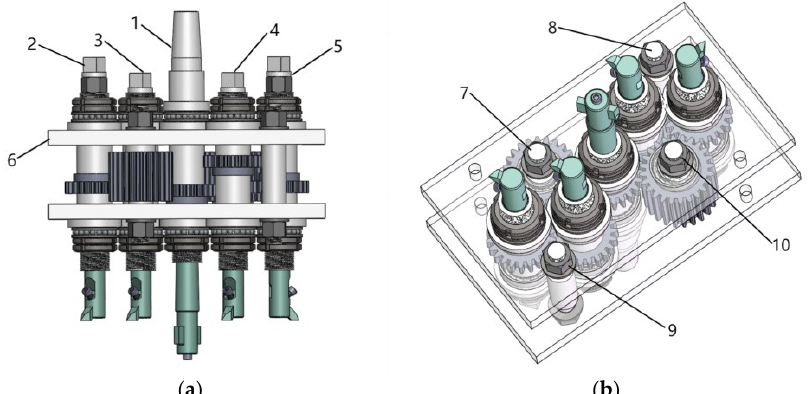
Figure 8. ( a ) Front view of the processing tool; ( b ) side view of processing tool shaft. The following parts are shown: 1, solar shaft; 2, planetary shaft I; 3, intermediate shaft I; 4, intermediate shaft II; 5, planetary shaft II; 6, support side plate; 7, power reversing shaft I; 8, limit shaft I; 9, limit shaft II; 10, power reversing